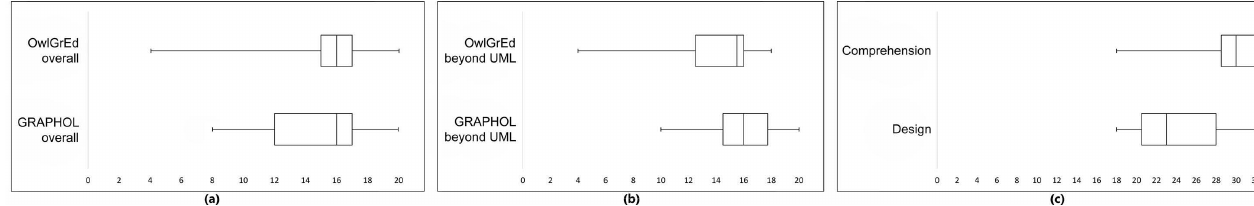
Figure 10. Correctness results for user tests. In boxplots ( a , b ) the scale is 0–20 (sum of correctness scores for five students on questions graded from 0 to 4); in boxplot ( c ) the scale is 0–32 (sum of correctness scores for eight students on questions graded from 0 to